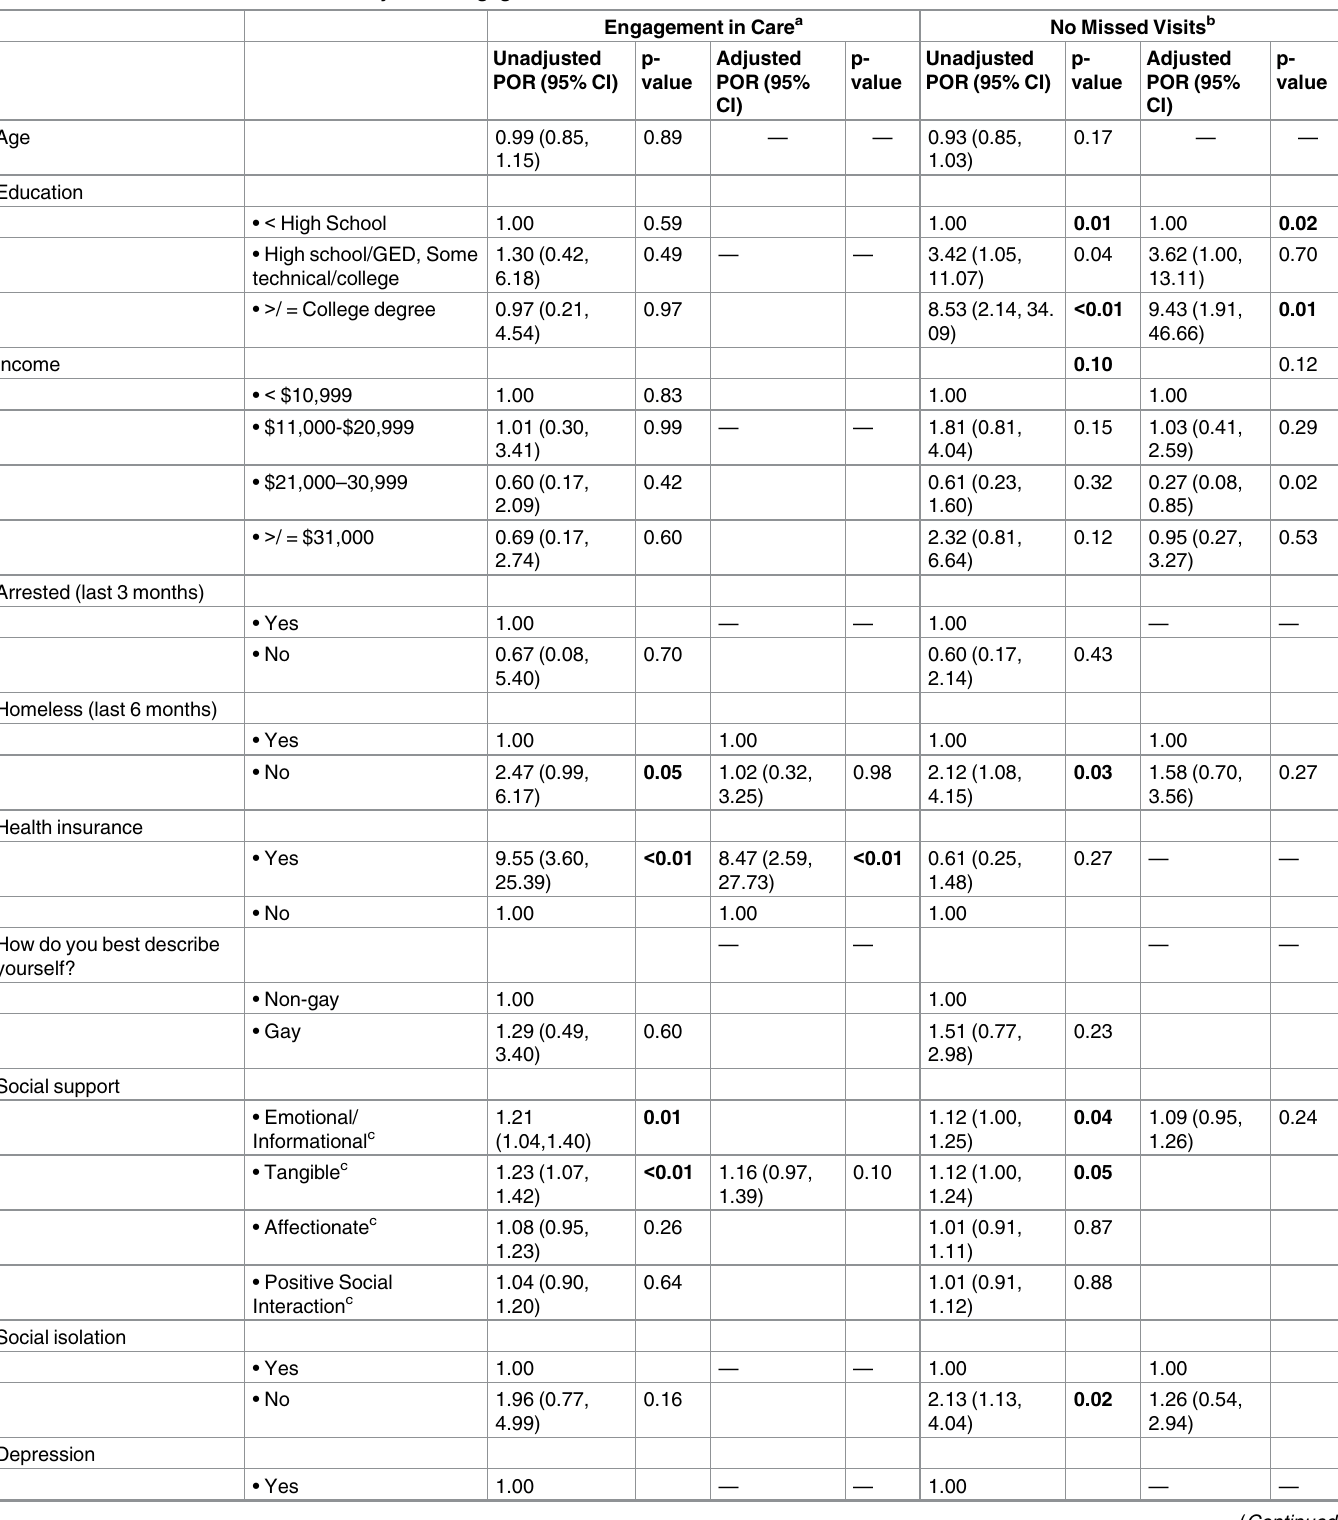
Table 2. Bivariable and multivariable analysis for engagement in care and no missed